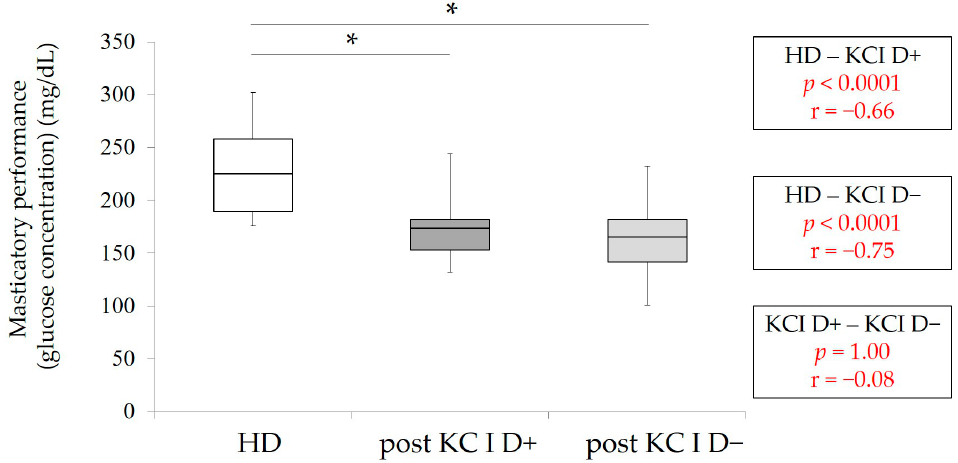
Figure 5. MPI in HD (control group), post-MPI in KC I D+ and D − . p > 0.05, Kruskal–Wallis with multiple comparison, r: effect size